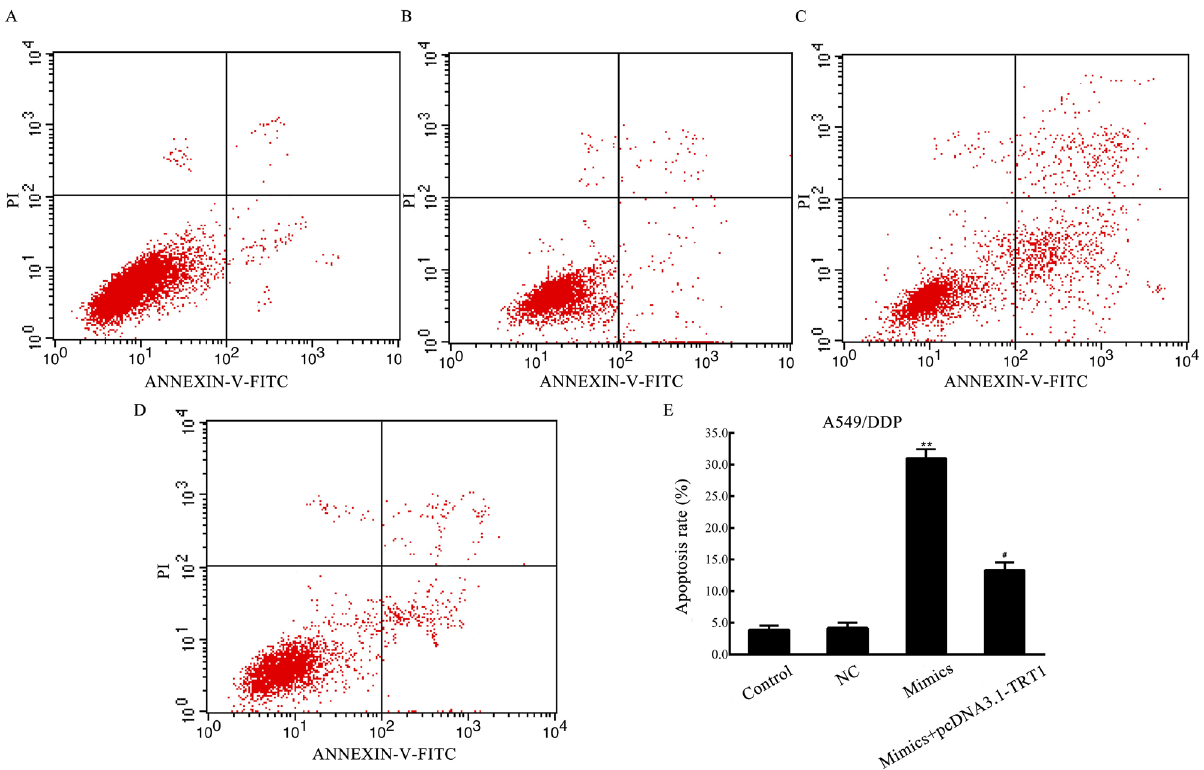
Figure 7: Effect of miR-1236-3p on the apoptosis of A549/DDP cells. (A) Control group; (B) NC group; (C) miR-1236-3p mimics group; (D) miR-1236-3p mimics+pcDNA3.1-TPT1 group; (E) Quantified results of the apoptosis rated of A-D was exhibited. ** P<0.01, mimics vs NC group. #P<0.05, mimics + pcDNA3.1-TPT1 vs mimics. Control, un-treated cells; NC, miR-1236-3p mimics negative control-transfected cells; miR- 1236-3p mimics, microRNA-1236-3p mimics-transfected cells; pcDNA3.1-TPT1, cells transfected with pcDNA3.1-TPT1; A549/DDP, human lung adenocarcinoma drug-resistant cell line; TPT1, tumor protein, translationally-controlled